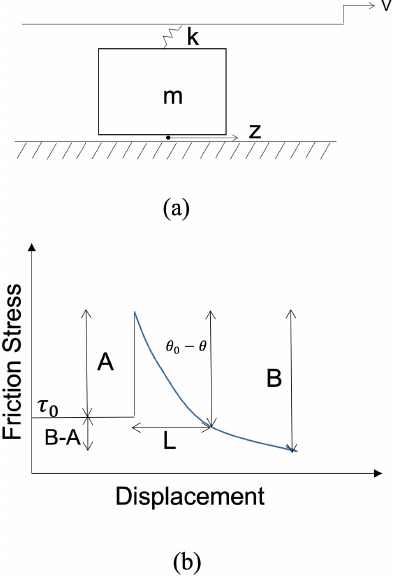
Figure 1. (a) The zero-dimensional (0D) spring–block representa- tion used in this study. k is the spring constant, v is the slip velocity and z ( = u ) is the slip. (b) A schematic diagram taken from Erick- son et al. (2008) illustrating the stress response to a step change in the imposed velocity v of a single spring–block slider